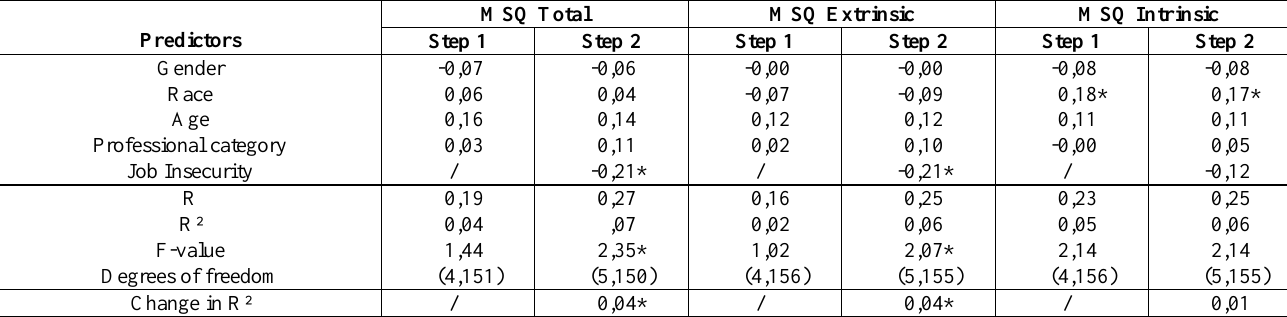
Table 3: Results of a regression analysis with job satisfaction (MSQ) as dependent variable, and background characteristics and job insecurity as predictors